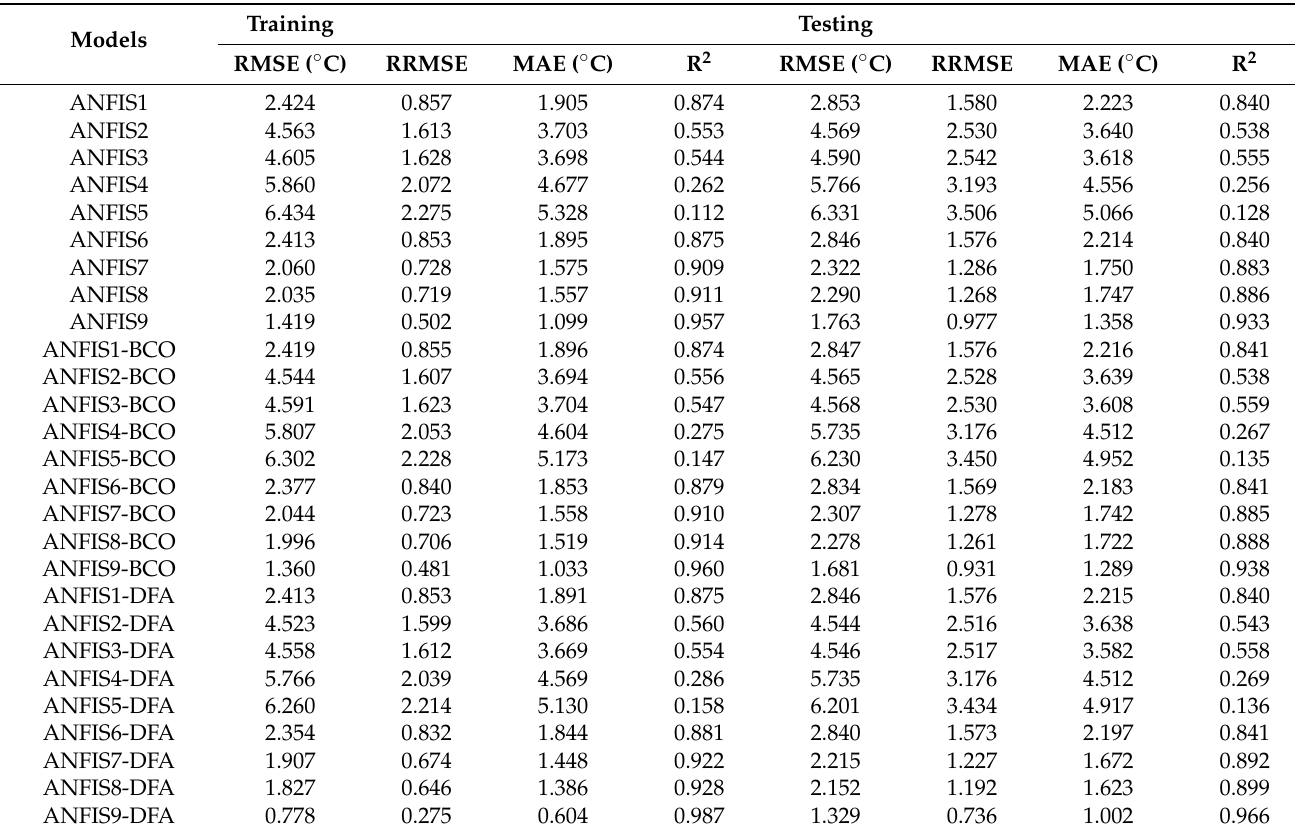
Table 5. Statistical metrics of the RMSE, RRMSE, MAE, R 2 for the classical and hybrid models developed at the Urmia